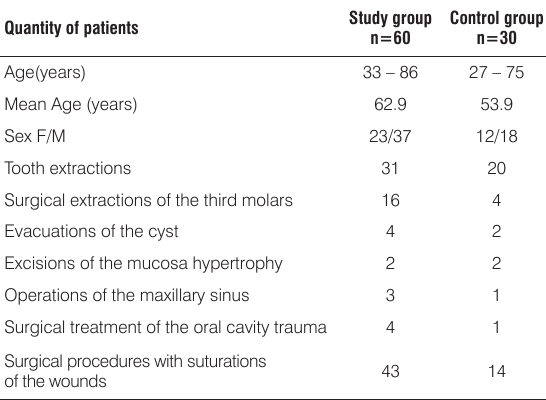
Table 1. Characteristics of the control and study group.